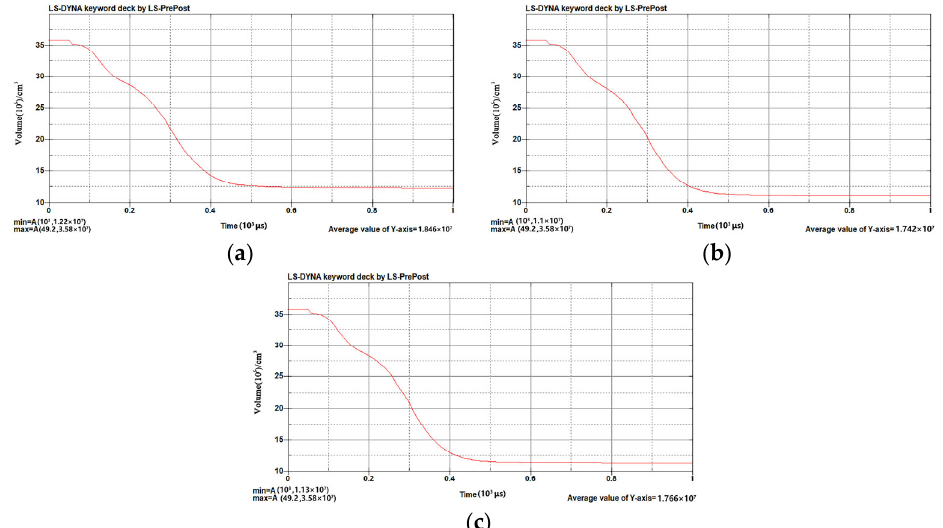
Figure 4. ( a ) Top ignition; ( b ) central ignition; ( c ) bottom ignition.